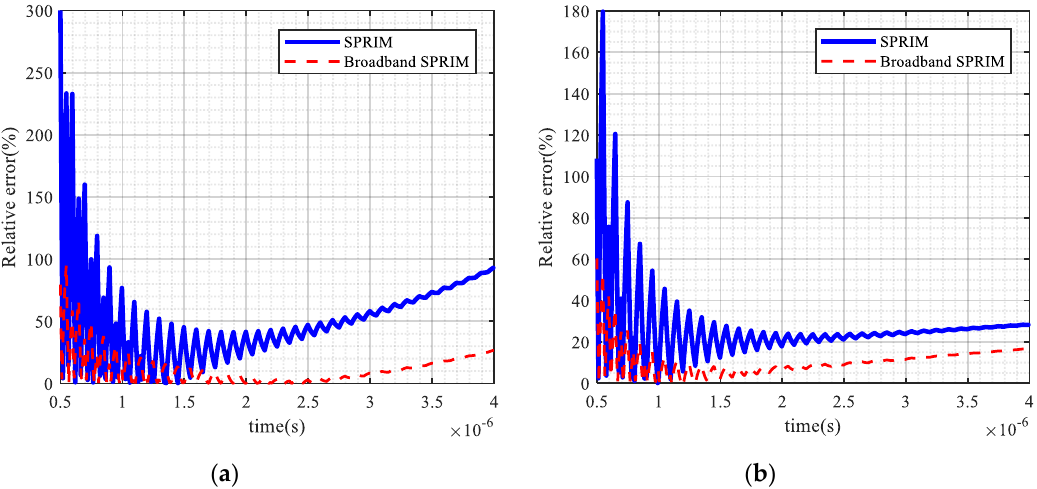
Figure 4. Relative errors of output response of the reduced model by using SPRIM and the proposed broadband SPRIM to those of the full-order circuit model under a square wave excitation of frequency f = 10 7 Hz, duty cycle = 0.5, reduced size = 12, and s = 1 × 10 5 for SPRIM. ( a ) y2. ( b ) y3.